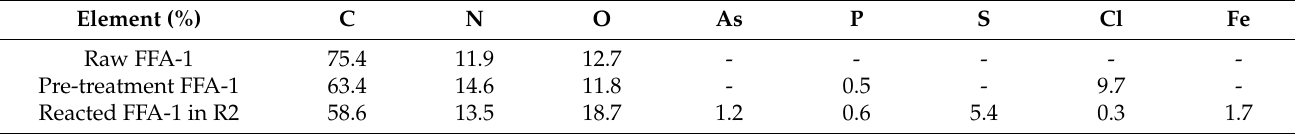
Figure 4. SEM observation of raw FFA-1 ( a ), reacted FFA-1 at the bottom ( b ) and the top ( c ) of R2. Table 1. Mass percentage of elements on the surface of FFA-1 via EDS